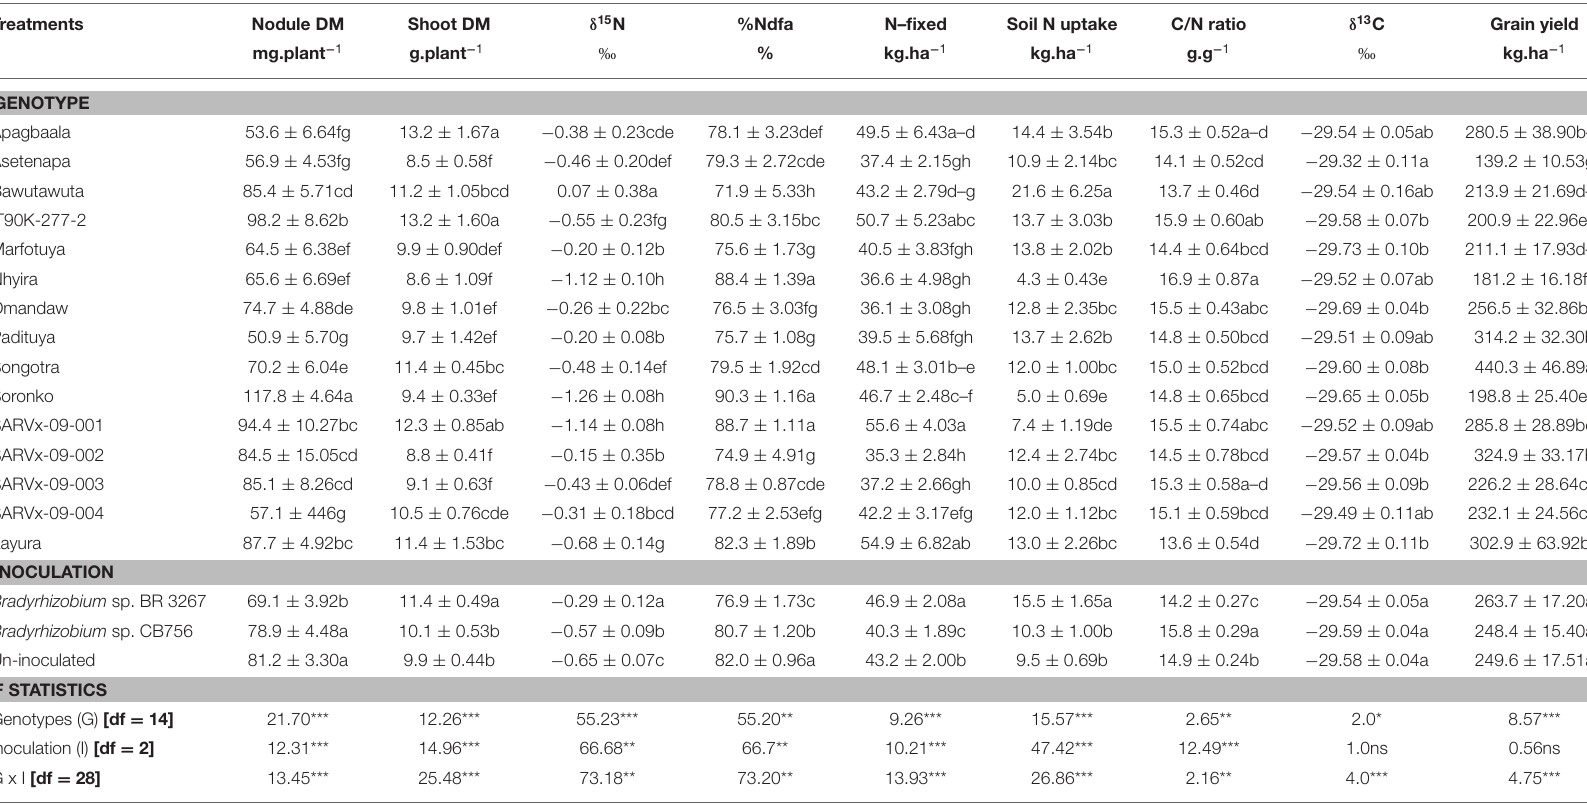
TABLE 4 | Nodulation, shoot dry matter (DM), symbiotic parameters, soil N uptake, δ 13 C, and grain yield of 15 cowpea genotypes inoculated with two Bradyrhizobium strains and planted in Gbalahi in 2013.